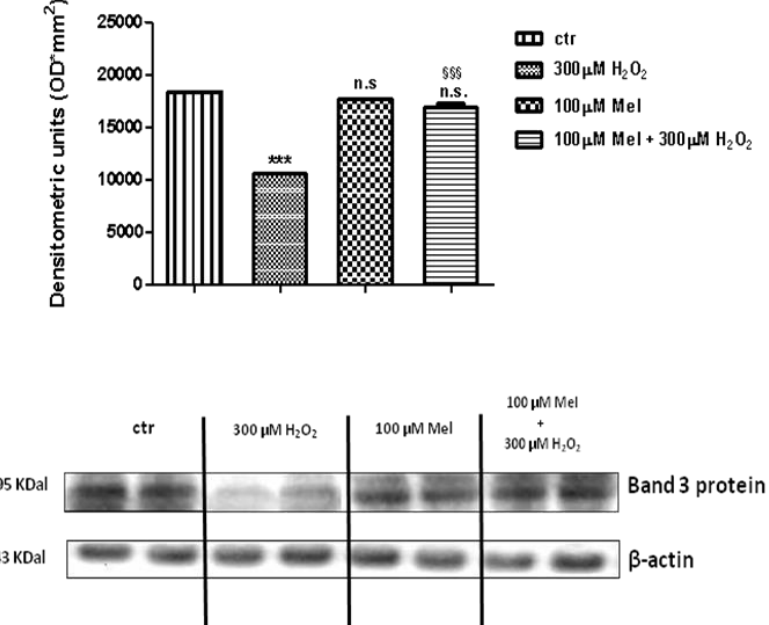
Figure 9. Expression levels of Band 3 protein measured in untreated erythrocytes (ctr), or in 300 μ M H 2 O 2 - or in 100 μ M Mel or in 100 μ M Mel + 300 μ M H 2 O 2 - treated erythrocytes, detected by Western blot analysis. *** p < 0.001 vs. ctr; n.s. not significant vs. ctr; §§§ p < 0.001 vs. 300 μ M H 2 O 2 , as determined by one way ANOVA followed by Bonferroni’s post hoc test (N = 5).